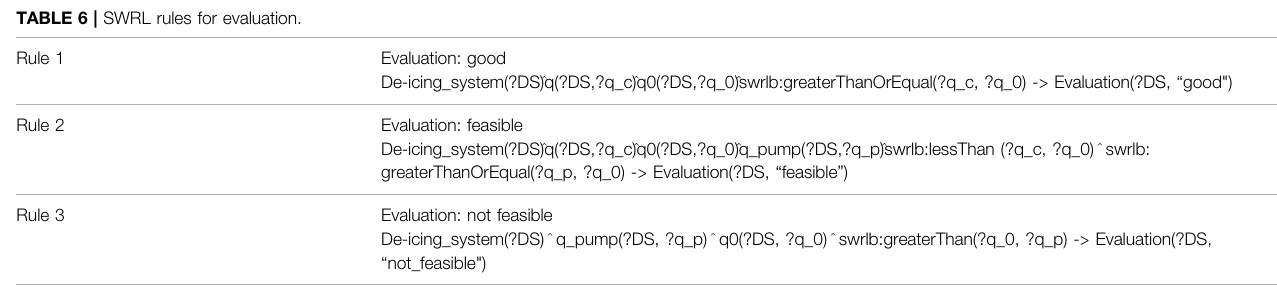
TABLE 6 | SWRL rules for evaluation.